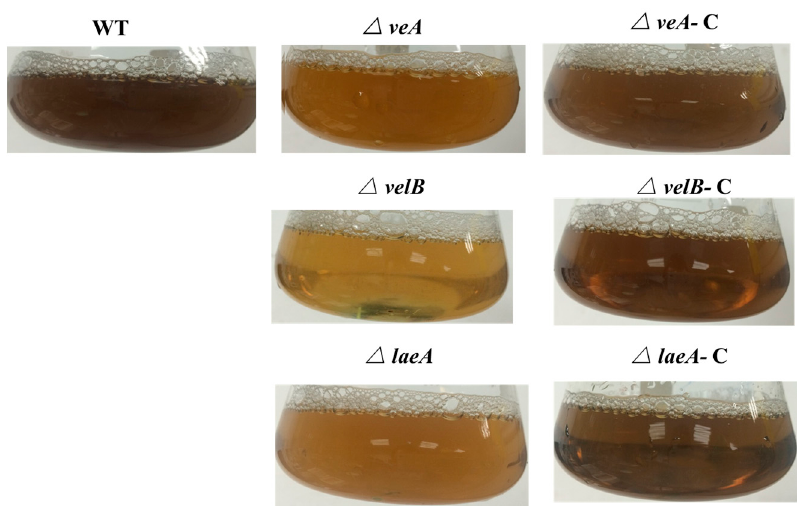
Figure 5. Impaired pigmentation in NK17, △ veA , △ velB , and △ laeA strains. The strains were incubated in PLB at 28 °C for seven days. Complemented strains restored to the level of the wild type.